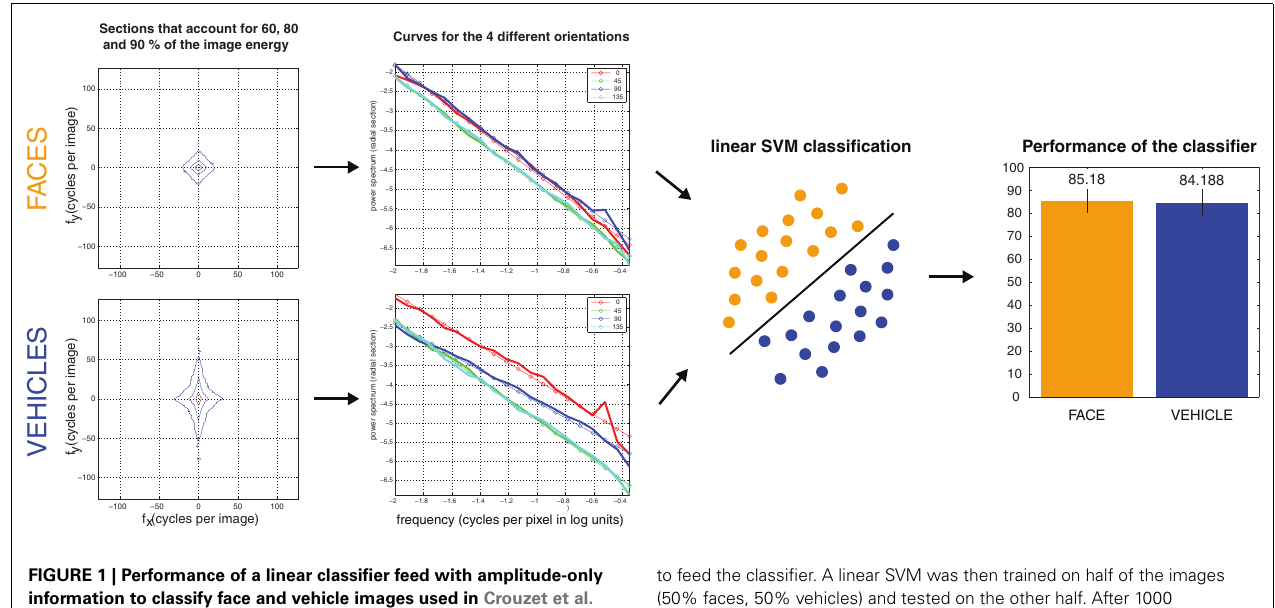
FIGURE 1 | Performance of a linear classifier feed with amplitude-only information to classify face and vehicle images used in Crouzet et al. (2010) . After having resized images to 256 × 256, they were passed trough a Hamming window function to remove boundary artifacts.The amplitude of the Fourier transform was then computed on each image.The resulting distribution of frequencies were divided into four bins of orientation (horizontal, vertical, and the two obliques), each one covering 45˚.The distribution of frequencies for each orientation was then encoded by 20 points, resulting in 80 values representing the global features of each image